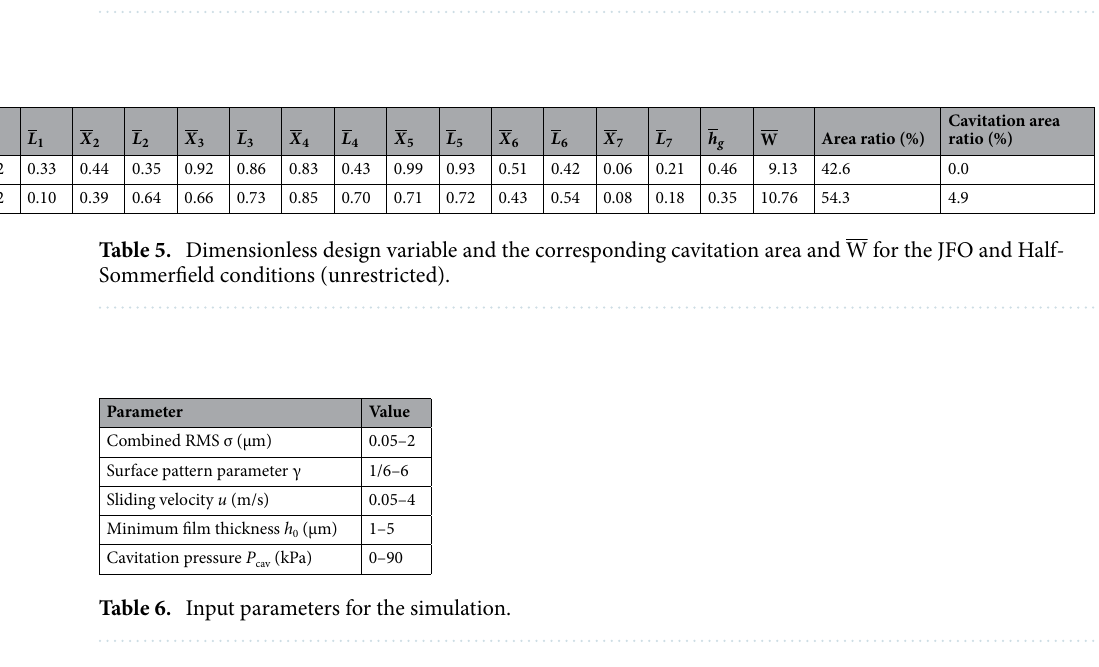
Table 4. Dimensionless design variables and the corresponding cavitation area ratio and W for the JFO and Half-Sommerfield conditions (area ratio = 30%).